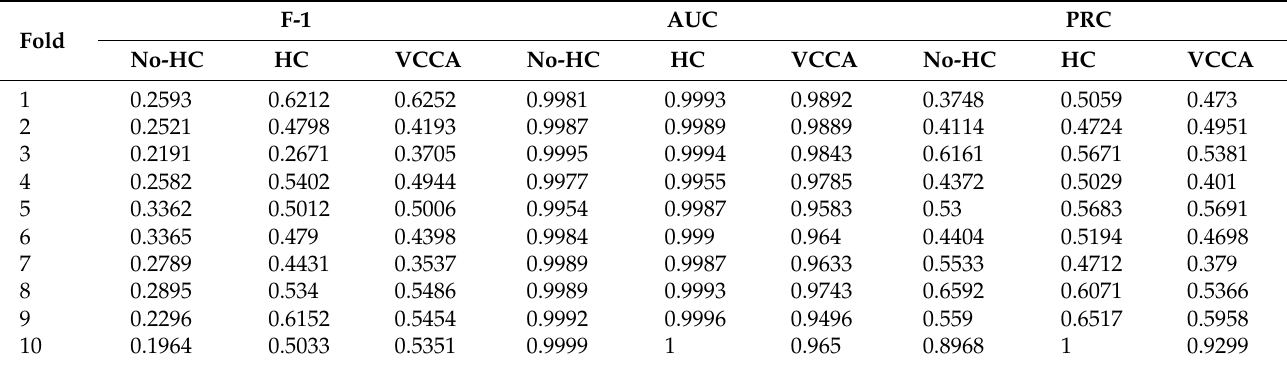
Table 10. The Mean of Metrics from Dataset 2.